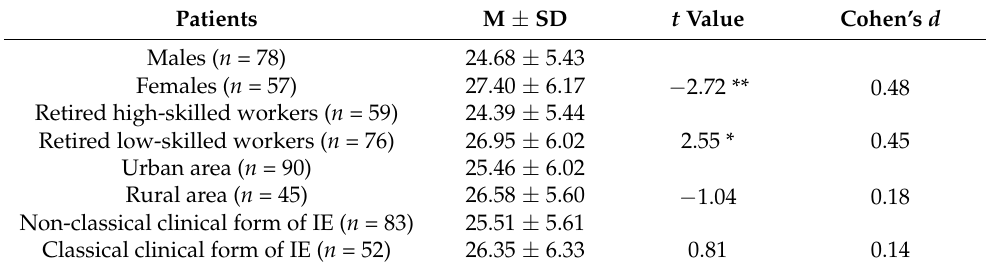
Table 1. Average scores of perceived stress among patients with infective endocarditis ( n = 135) according to gender, work type, residence area and clinical form of IE.